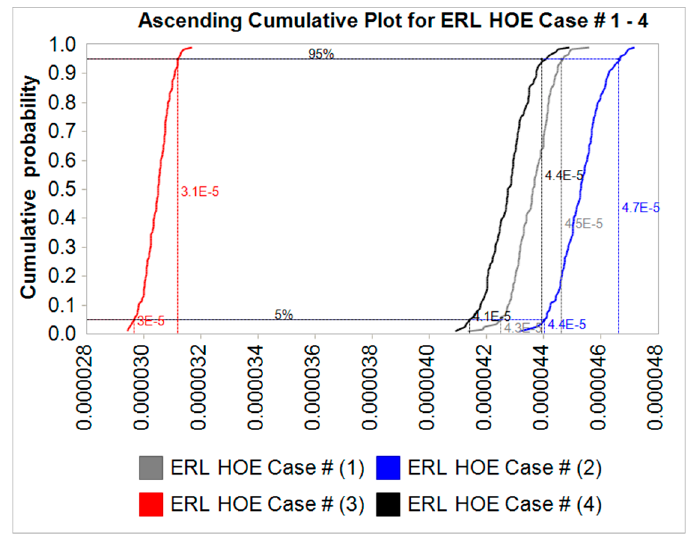
Figure 15. ERL Cumulative distribution plots—HOE Case #1 to #4.